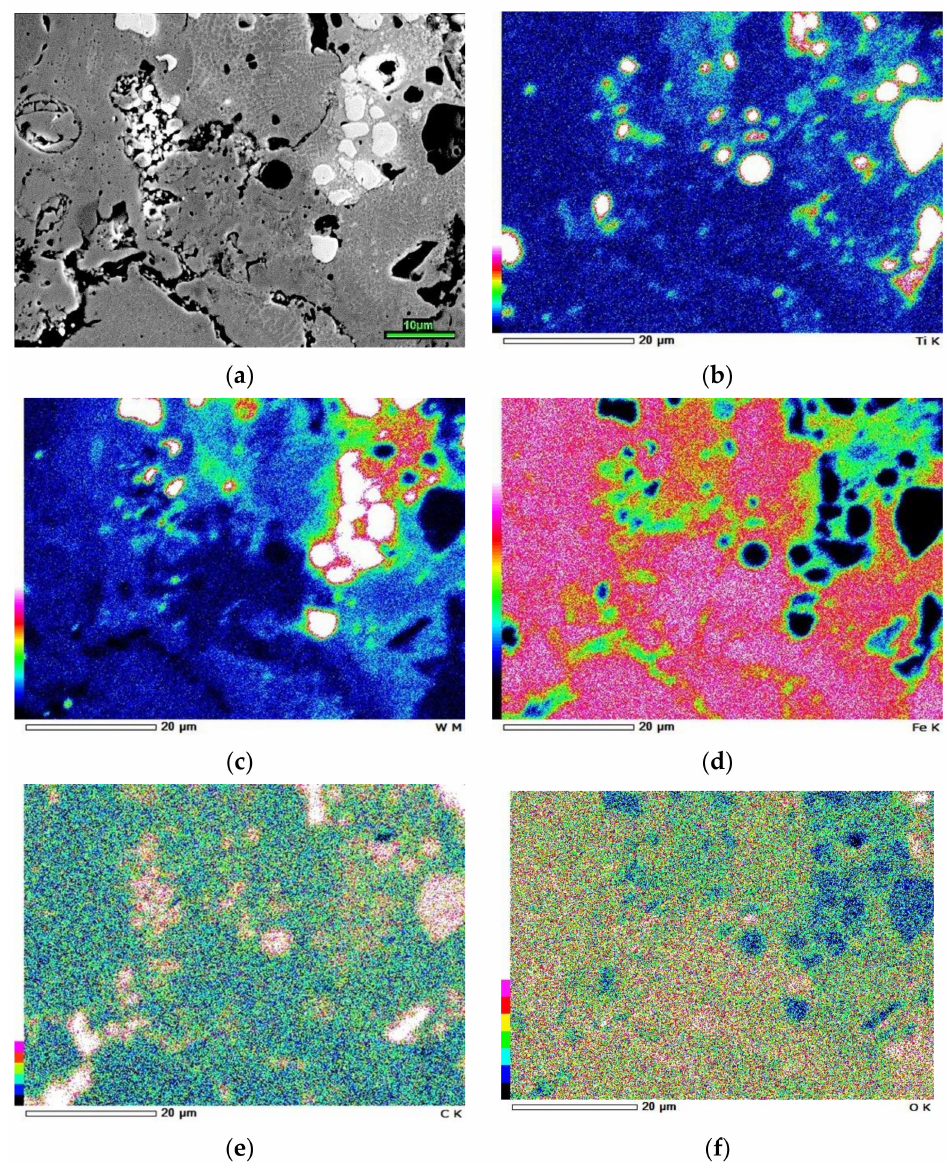
Figure 8. Elemental EDX-mapping of the coating: ( a ) SEM(BSEI), distribution of ( b ) Ti, ( c ) W, ( d ) Fe, ( e ) C, ( f )